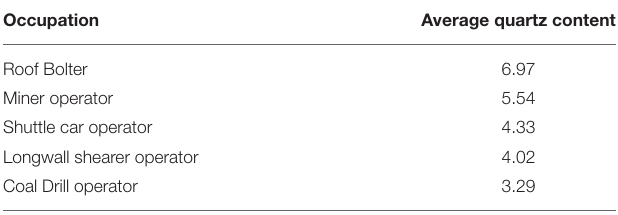
TABLE 6 | Components of commercially produced carbon blacks * .